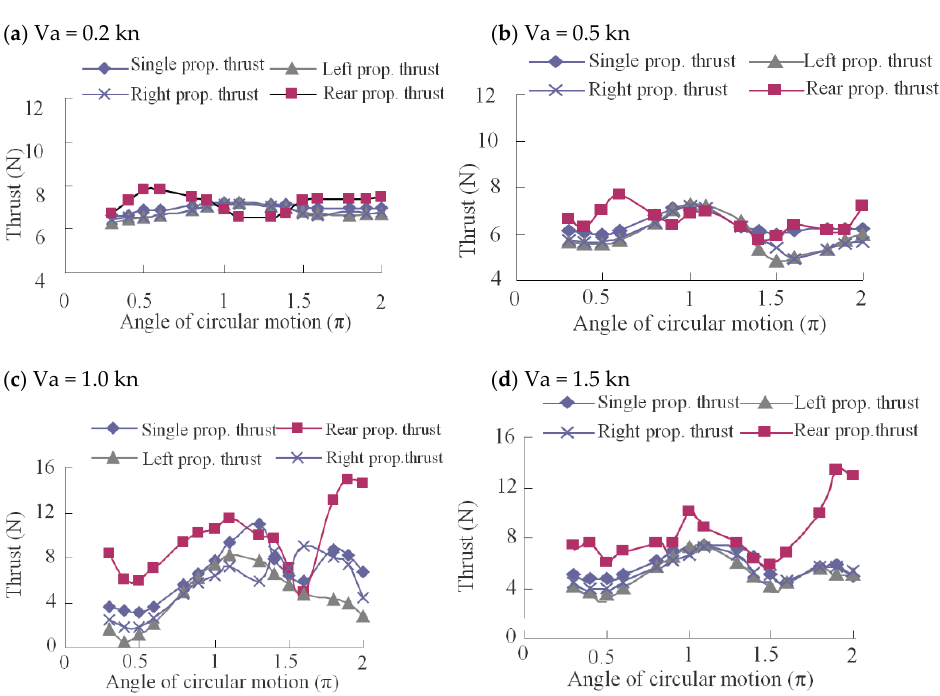
Figure 16. Thrust curves of the two-dimensional circular motion of the underwater robot system. ( a ) Va = 0.2 kn; ( b ) Va = 0.5 kn; ( c ) Va = 1.0 kn; ( d ) Va = 1.5 kn.